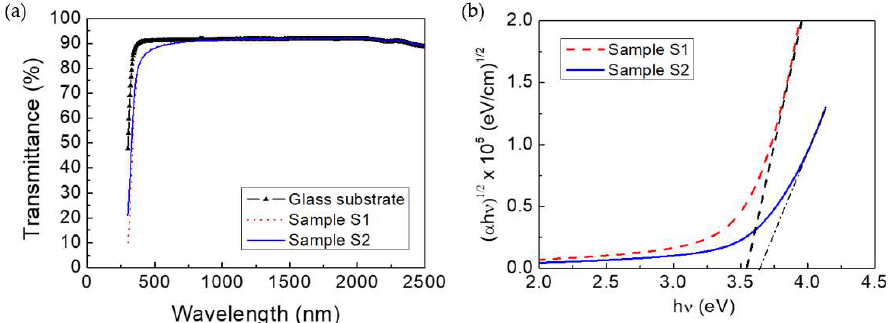
Figure 4. ( a ) Transmittance spectra and ( b ) Tauc’s plot for the TiO 2 films deposited at 0.17 (red dash line) and 0.89 Pa (blue line).